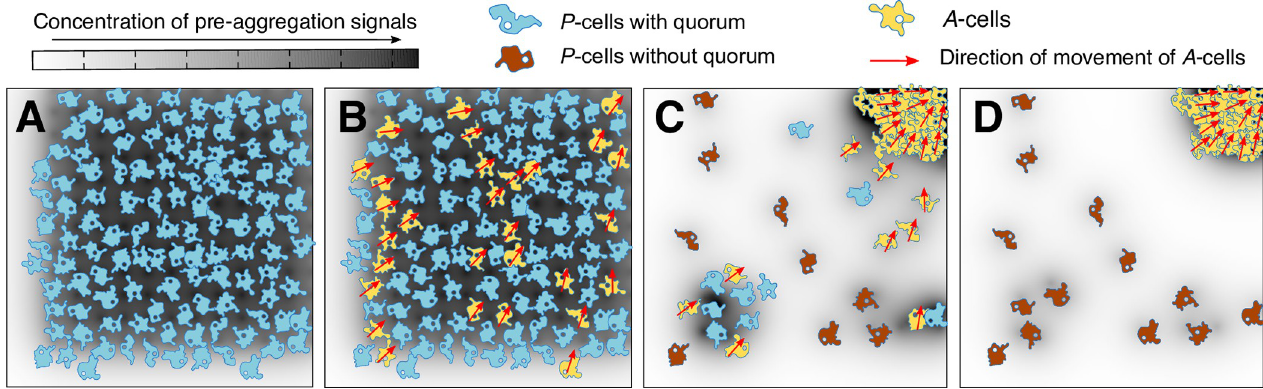
Fig 2. Developmental model schematic. (A) At high initial densities, all P -cells have a quorum to initiate aggregation. (B) With a strain-specific probability, some P -cells transition into A -cells. (C) As A -cells aggregate, some of the P -cells that did not transition into A -cells are left without a quorum. These are the loners. (D) At the end of development, P -cells far from the aggregate location are more likely to have been left without a quorum and to stay as loners.